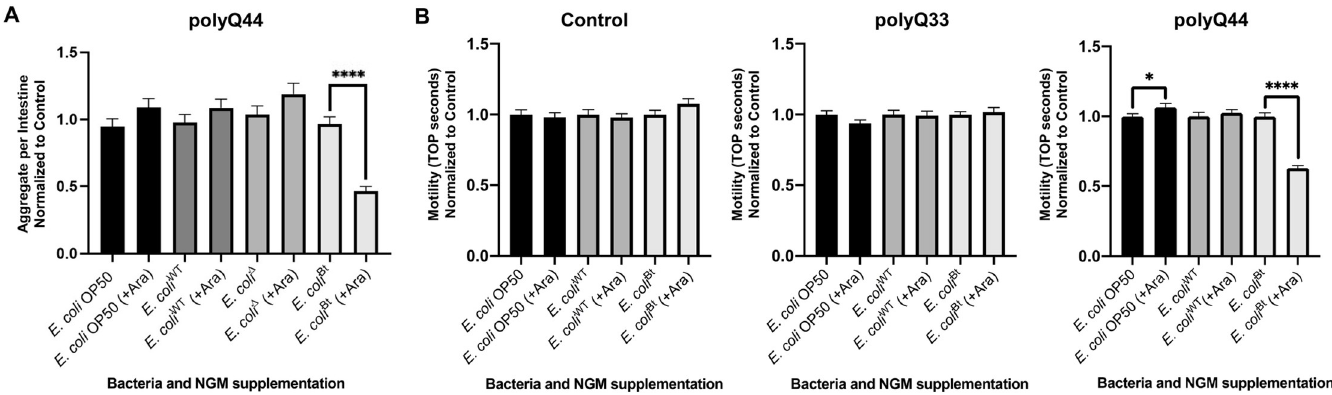
Fig 8. Butyrate-producing E . coli suppresses aggregation and the associated toxicity. Animals were fed four different strains of bacteria: non-butyrogenic controls ( E . coli OP50, E . coli WT , E . coli Δ ) and conditional butyrogenic E . coli ( E . coli Bt ). A) The graphs represent the average number of intestinal polyQ44 aggregates per worm normalized to the control (no arabinose). Each bar is an average of three independent experiments with a total of 100 animals. B) Intestinal aggregate-dependent toxicity normalized to the control (no arabinose) assessed with the TOP phenotype. The left panel represents roller worms (Control), the middle panel represents polyQ33 worms, and the right panel represents worms expressing polyQ44. Each bar is an average of three independent experiments with a total of 60 animals. Error bars represent SEM. Statistical significance between each pair was calculated using Student’s t-test ( � p < 0.05, ���� p < 0.0001).